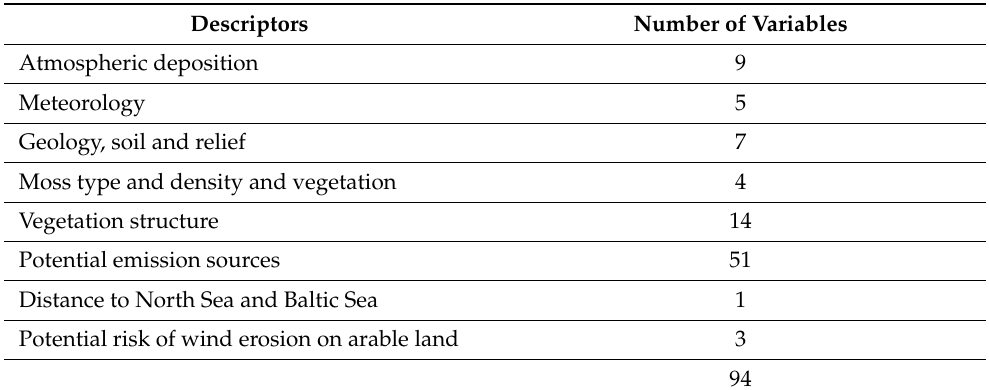
Table 2. Site- and region-specific descriptors of element concentrations in mosses.